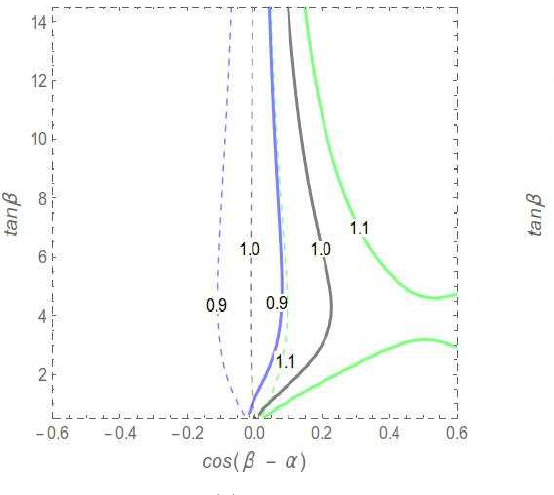
h ) /σ ( gg h ) SM , (b) Br ( h V V ) /Br ( h V V ) SM → → → →